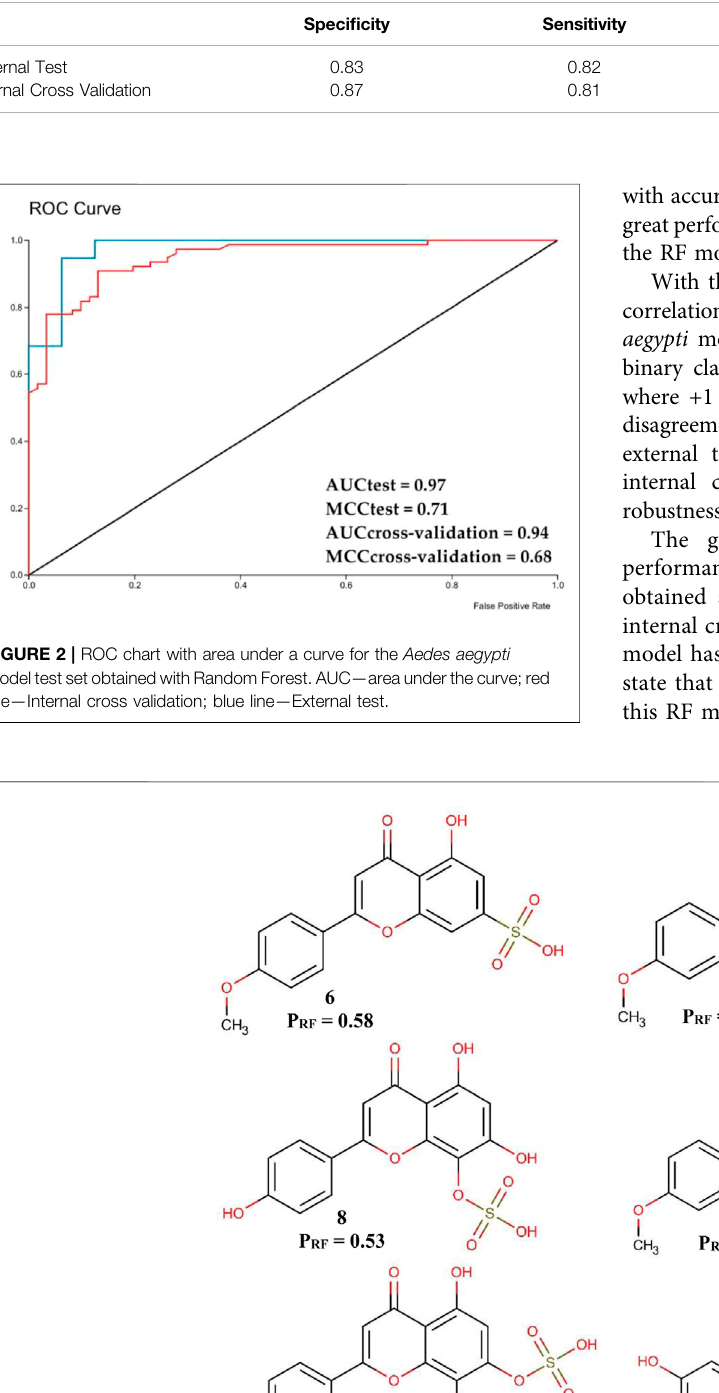
TABLE 3 | Summary of parameters corresponding to the results obtained in all models.